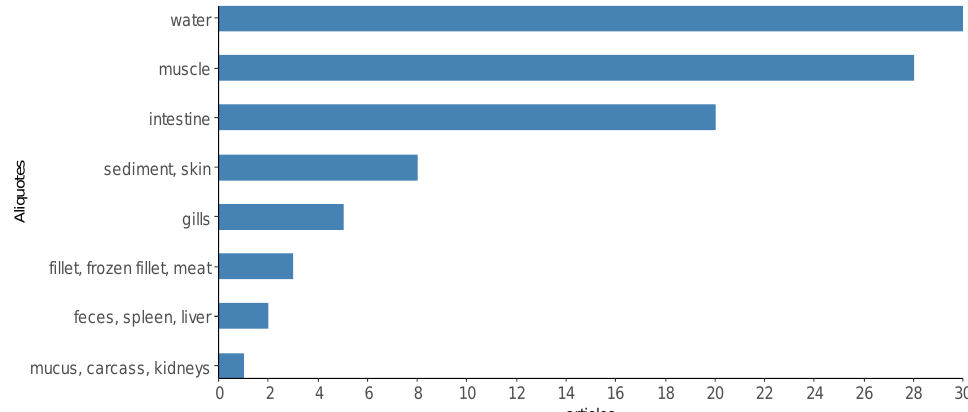
Figure 9. Most analyzed sample aliquots in the scientific articles selected by the integrative review on the microbiological diagnoses of Salmonella spp. In aquaculture between 2000 and 2020.